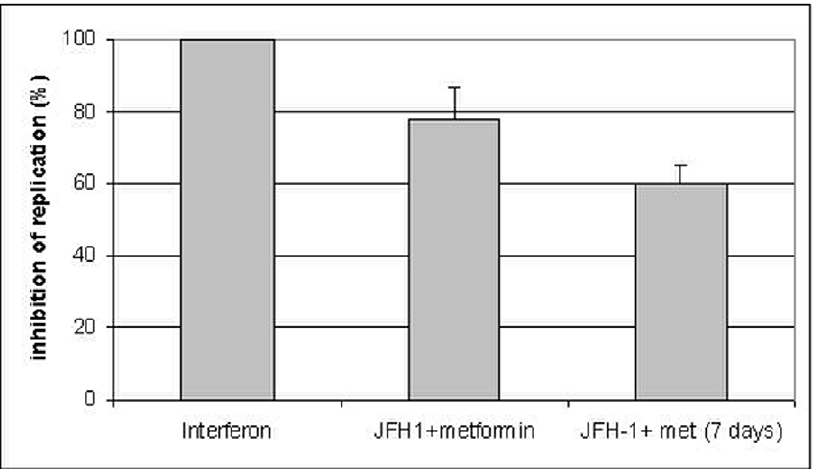
Figure 5. Metformin (2 mM) inhibits viral replication in vitro. Huh7.5 cells treated with interferon (500 IU/ml) were used as a positive control for inhibition of viral replication (100%). Cells were infected with JFH1 and treated with metformin for 48 hours and 7 days. Metformin significantly inhibited viral replication (p , 0.05).